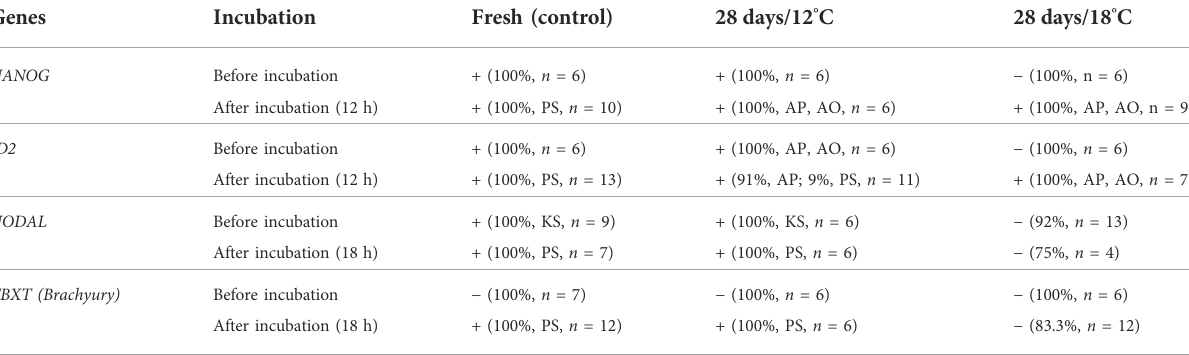
TABLE 3 Summary results of expression of genes in embryos before and after incubation. Embryos were stored for 28 days at 18 ° C (28 days/18 ° C) or 12 ° C (28 days/18 ° C) and incubated at 37.8 ° C for 12 h for NANOG and ID2 , and for 18 h for NODAL and TBXT . Freshly laid eggs, before and after incubation were used as controls. The embryos were isolated, fi xed and stained by WMISH with NANOG , ID2 , NODAL , and Brachyury (TBXT) probes. ( − ) indicates downregulated expression of the genes, whereas (+) indicates maintained or restored expression. The percentage of embryos in each groups and their count is given. Speci fi c spatial expression in the Koller ’ s sickle (KS), Area Opaca (AO), Area pellucida (AP), or the Primitive streak (PS), is noted.